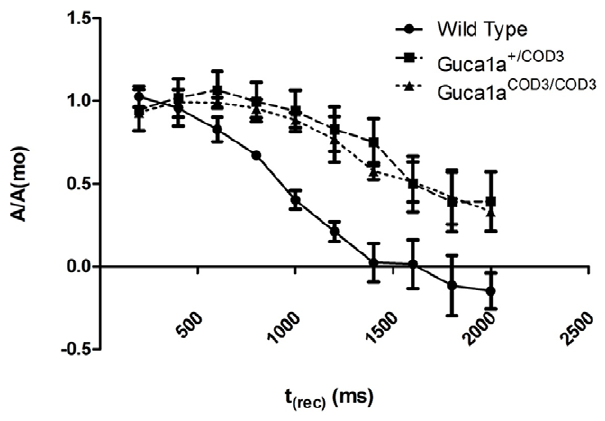
Figure 5. Impaired recovery from bright flash of Guca1a COD3 ‘knock-in’ mice. T he a-wave amplitude from a bright test flash, presented at varying times after a conditioning flash, is plotted as a proportion of the amplitude elicited by the conditioning flash. A value of 0 indicates the amplitude from the second flash is the same as that from the first; full recovery from a bright conditioning flash occurs within two seconds in wild-type mice, and the second flash elicits an amplitude half that of the first when the inter-stimulus interval is approximately 1000 ms. This recovery time is extended to 1600 ms in both heterozygous and homozygous knock-in mice, whilst the amplitude from the second flash fails to reach that elicited by the first flash during the time period of